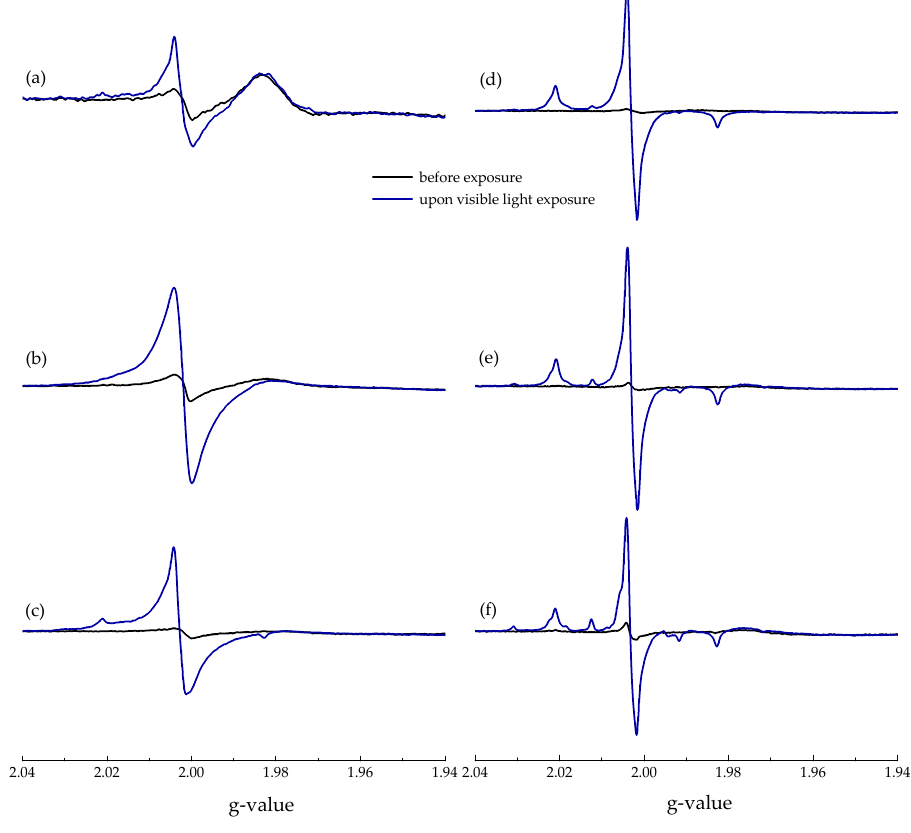
Figure 2. X-band EPR spectra obtained before and upon visible (VIS)-light exposure (160 klx) of nanocrystalline photocatalysts: ( a ) M1; ( b ) M2; ( c ) M3; ( d ) M4; ( e ) M5; and ( f ) M6 at 100 K.